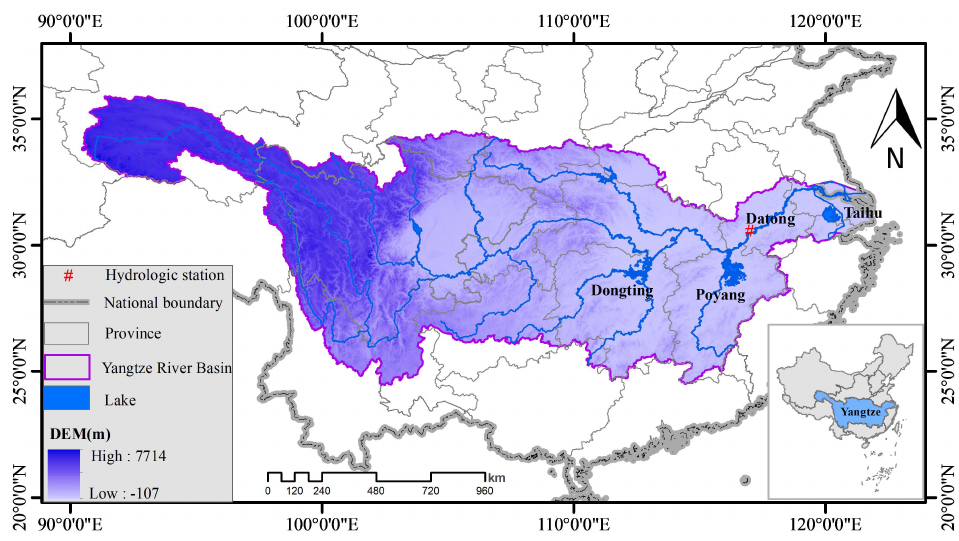
Figure 1. The Yangtze River Basin in